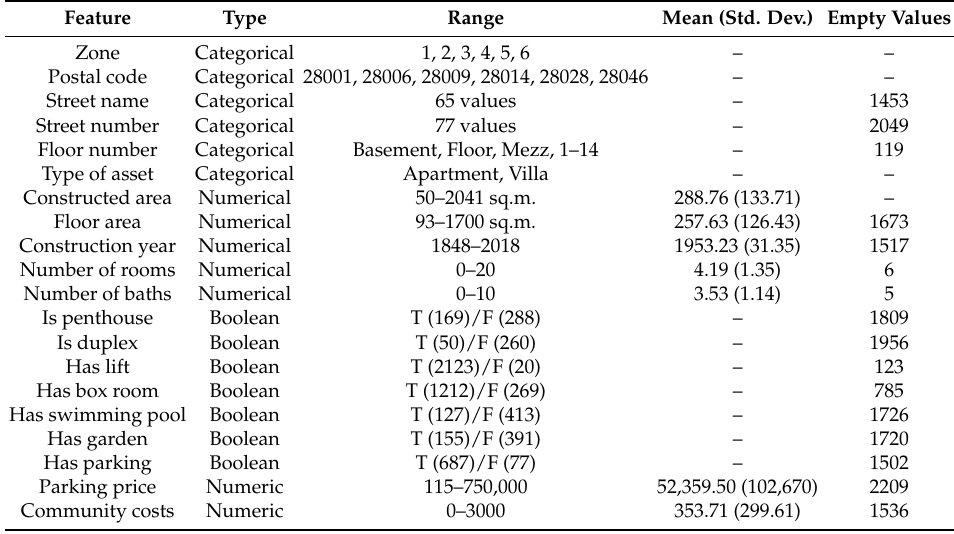
Table 1. Data description, showing the range of values for each feature and the number of empty values, as well as mean and standard deviation in the case of numerical